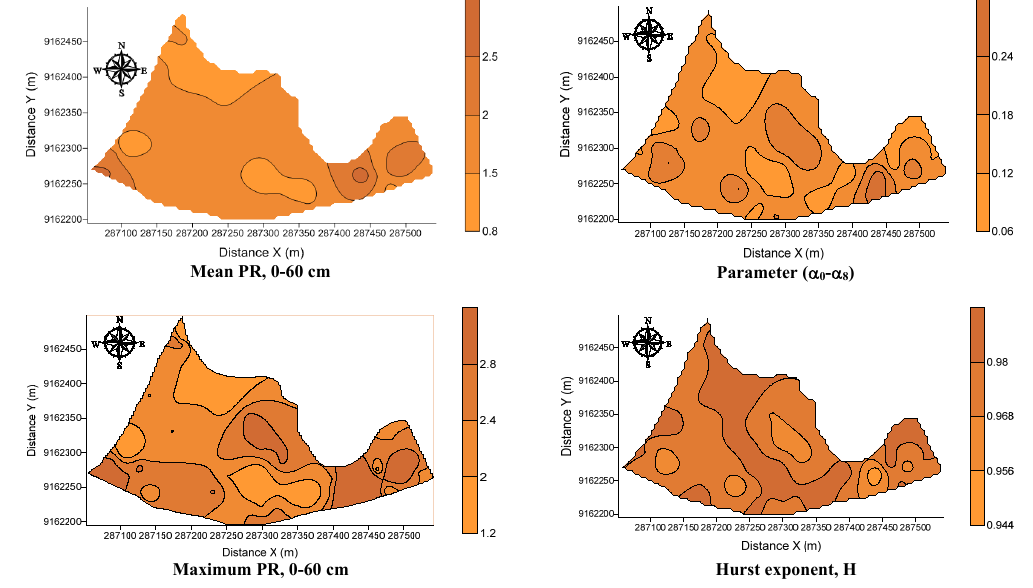
Fig. 7. Maps at the field scale of maximum and mean PR, parameter ( α 0 − α 8 ), and Hurst exponent, H